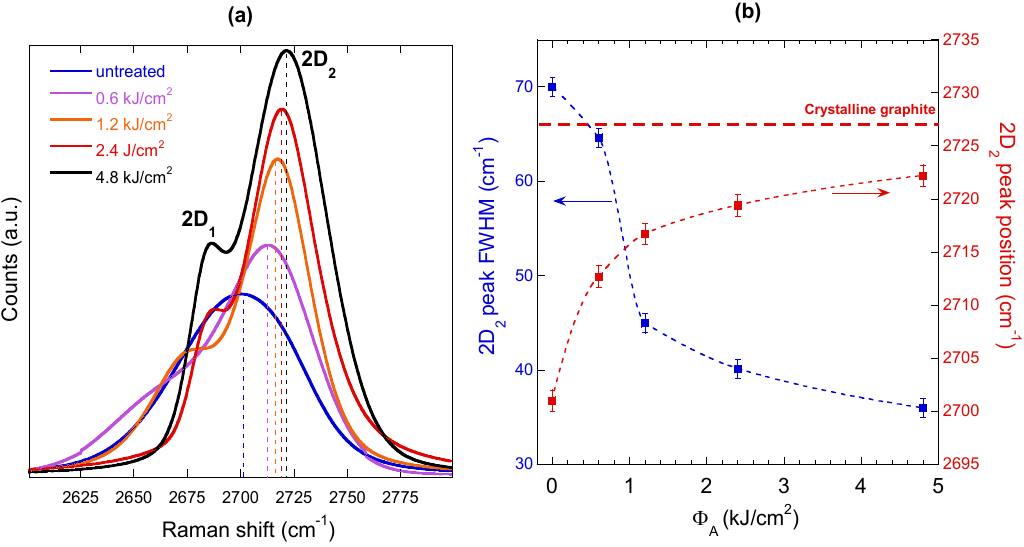
Figure 8. ( a ) 2D band region of the measured Raman spectra reported in Figure 5, ( b ) 2D 2 peak FWHM (blue curve) and position (red curve) as a function of the total accumulated laser fluence. Red dashed line at 2727 cm −1 indicates the 2D 2 peak position of crystalline graphite when a 514.5 nm laser is used for Raman analysis [39]. For the untreated case ( Φ A = 0), data refer to the 2D single peak.